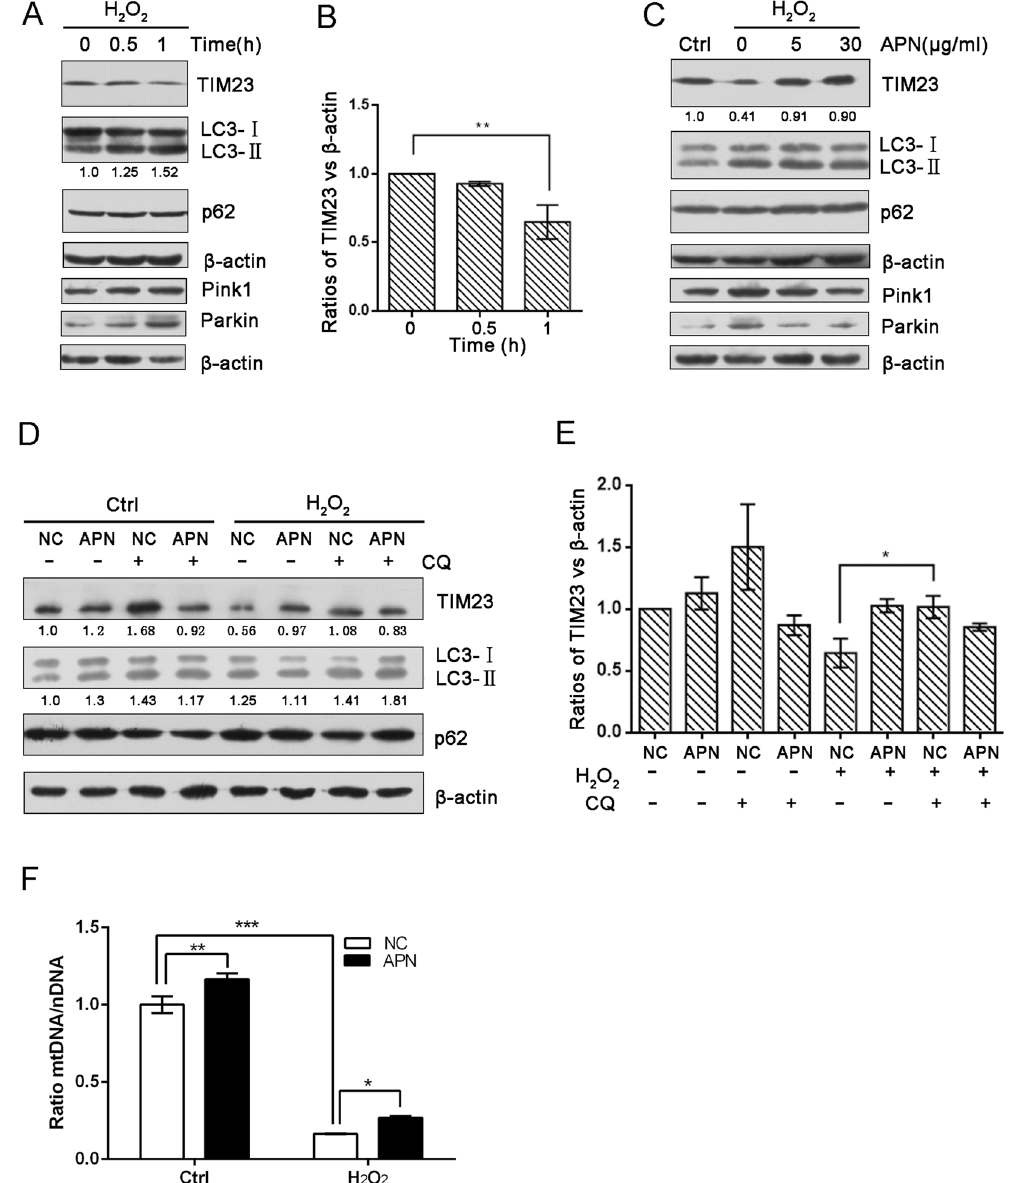
Figure 5. APN suppresses H 2 O 2 -induced mitophagy. ( A ) C2C12 cells were treated with 5 mM H 2 O 2 for the indicated periods. Samples were collected for western blotting to analyze the expression of TIM23, LC3, p62, Pink1, Parkin and β -actin. ( B ) The densitometric ratios of mitochondrial marker proteins and LC3 were quantified using Image J software. The analysis of the TIM23/ β -actin ratios from the immunoblots is shown (data from three independent experiments). ( C ) C2C12 cells pretreated or not with various concentrations of APN followed by treatment with 5 mM H 2 O 2 for 1 h. Western blotting was performed to analyze the levels of TIM23, LC3, p62, Pink1, Parkin and β -actin. ( D ) C2C12 cells pretreated with APN or not were exposed to CQ (60 μ M) for 4 h, followed by incubation with or without 5 mM H 2 O 2 for 1 h. Western blotting was performed to analyze the levels of TIM23, LC3, p62 and β -actin. ( E ) Image J densitometric analysis of the TIM23/ β -actin ratios from the immunoblots is shown (data from three independent experiments) ( * p < 0.05, ** p < 0.01). ( F ) Quantification of mitochondrial DNA copy number in NC or APN pretreated cells treated with H 2 O 2 (data from three independent experiments, * p < 0.05, ** p < 0.01, *** p <